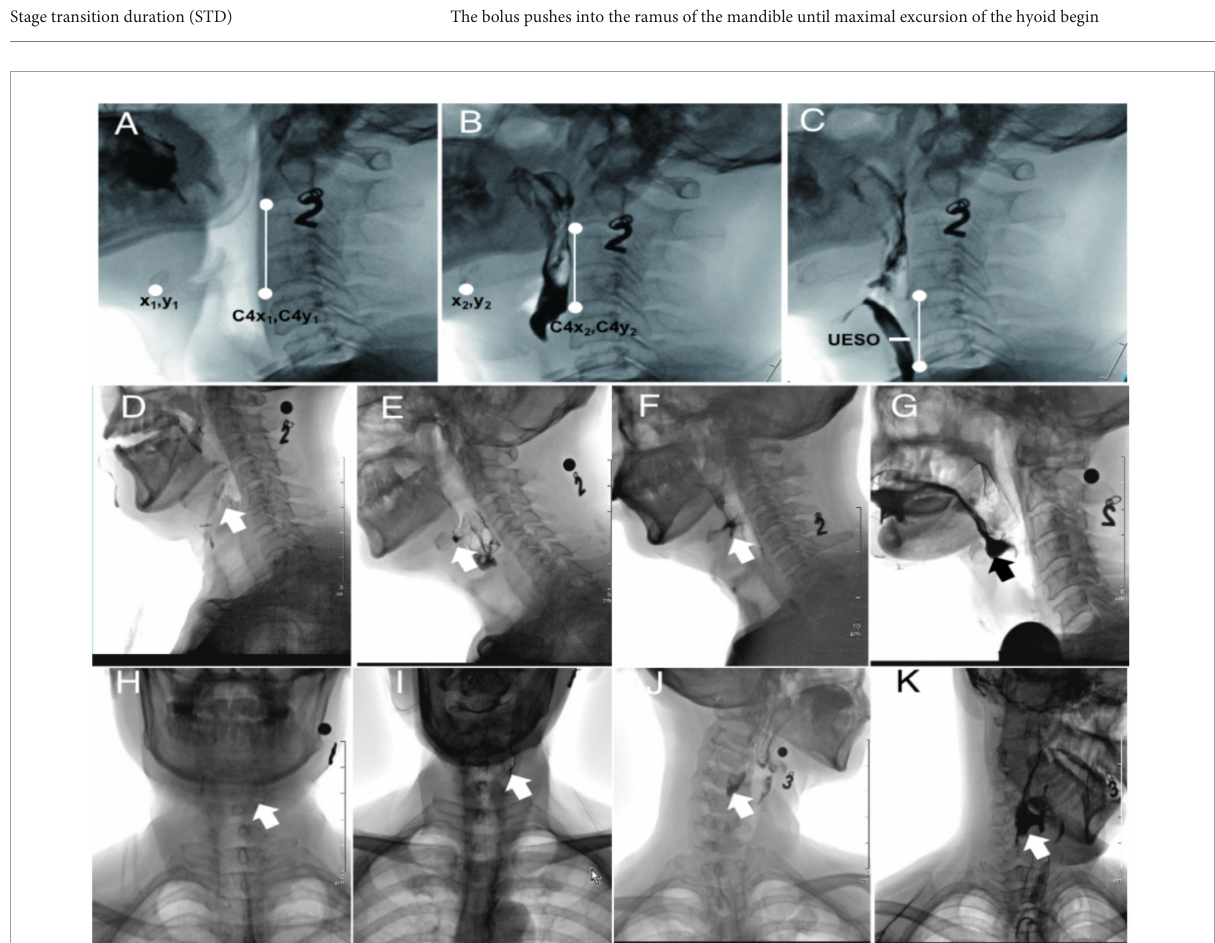
FIGURE1 The extraction method of HAD, HSD, UESO, and PRG from VFSS. Number “2” and “3,” oral contrast agent 2 and 3 (thickened liquid); (A) hyoid resting position (after rotation); (B) highest hyoid position (after rotation); (C) the maximum upper esophageal sphincter opening position (after rotation); (D) PRG 0 (no residue); (E) PRG I (mild residue); (F) PRG 2 (moderate residue); (G) PRG 3 (severe residue) of the valleculae; (H) PRG 0 (no residue); (I) PRG 1 (mild residue); (J) PRG 2 (moderate residue); and (K) PRG 3 (severe residue) of the pyriform sinuses. HAD, hyoid bone anterior-horizontal displacement; HSD, hyoid bone superior-horizontal displacement; UESO, upper esophageal sphincter opening; PRG, Pharyngeal Residual Grade; VFSS, videofluoroscopic swallowing